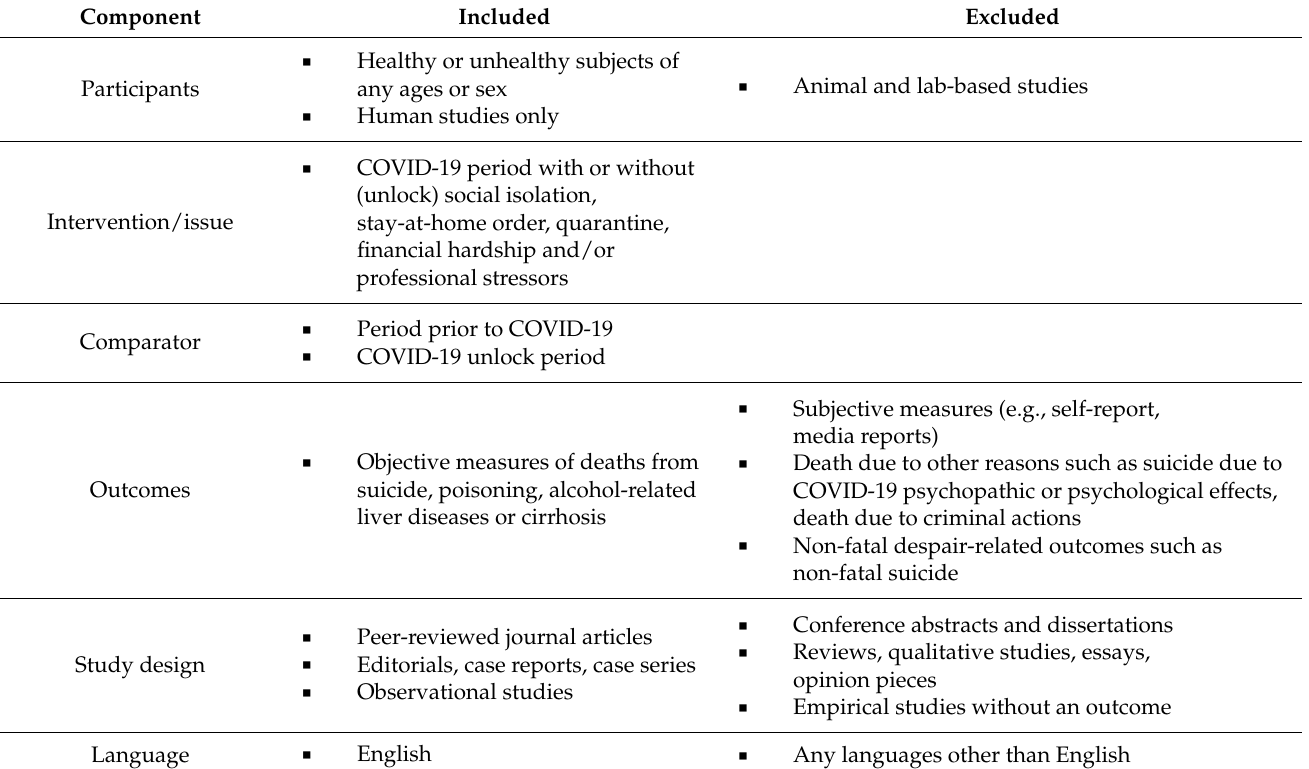
Table 1. Inclusion and exclusion criteria of the